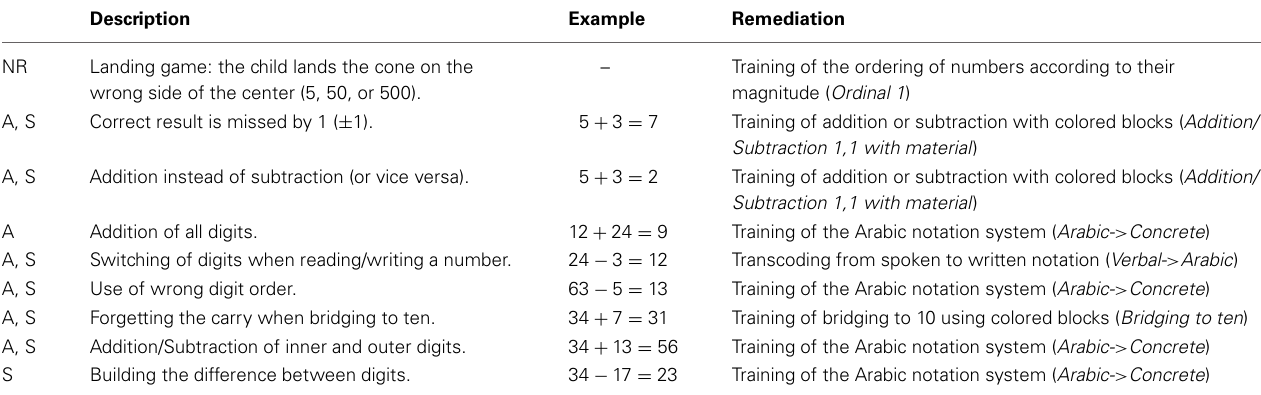
Table 1 | Description of typical errors along with examples and remediation games for the domains of number representations (NR), addition (A) and subtraction (S).